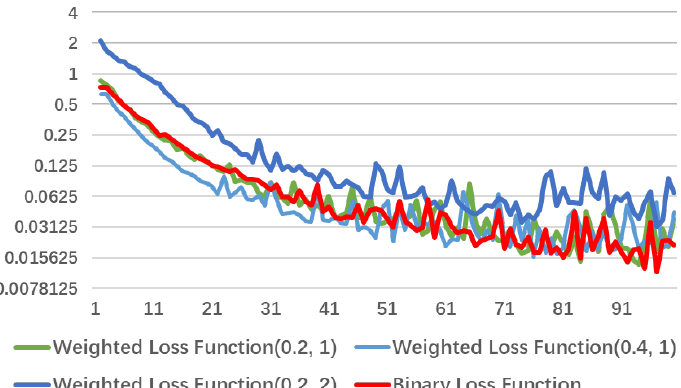
Figure 9. Loss convergence of binary cross-entropy loss function, weighted loss (0.4, 1), focal loss (0.2, 2), and weighted loss (0.2, 1) in the first 100 steps.